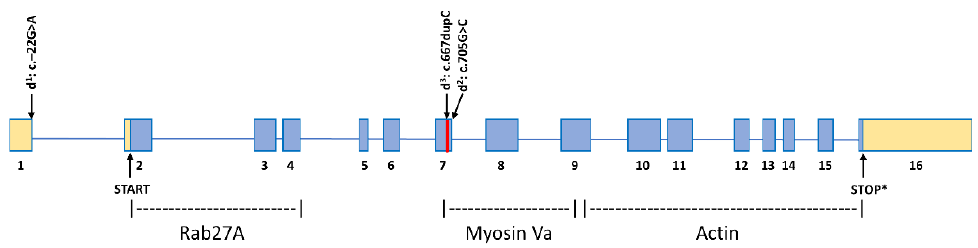
Figure 5. Locations of the d 1 , d 2 and d 3 variants within the MLPH gene. Exons are boxes, protein coding regions are blue and non-coding regions are tan. Protein interaction domains were adapted from a previous analysis in rabbit and American mink [18,21].